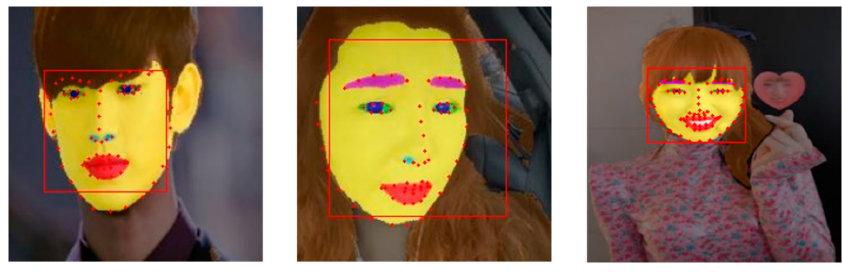
Figure 5. Results of facial landmark point extraction.